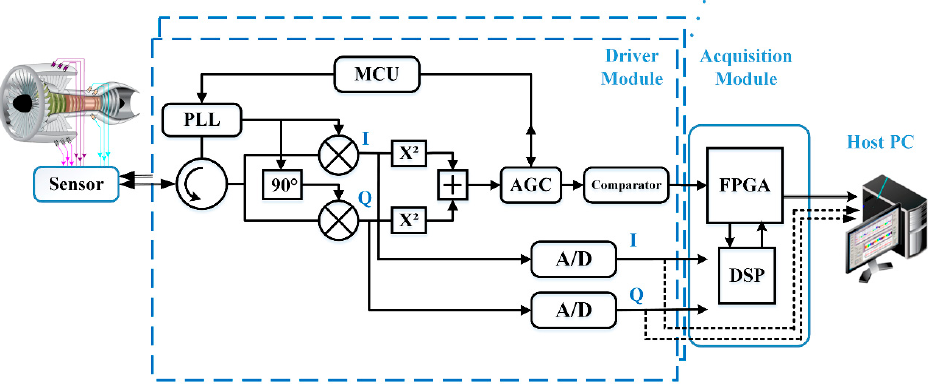
Figure 2. Structure of the microwave blade tip timing and tip clearance system.